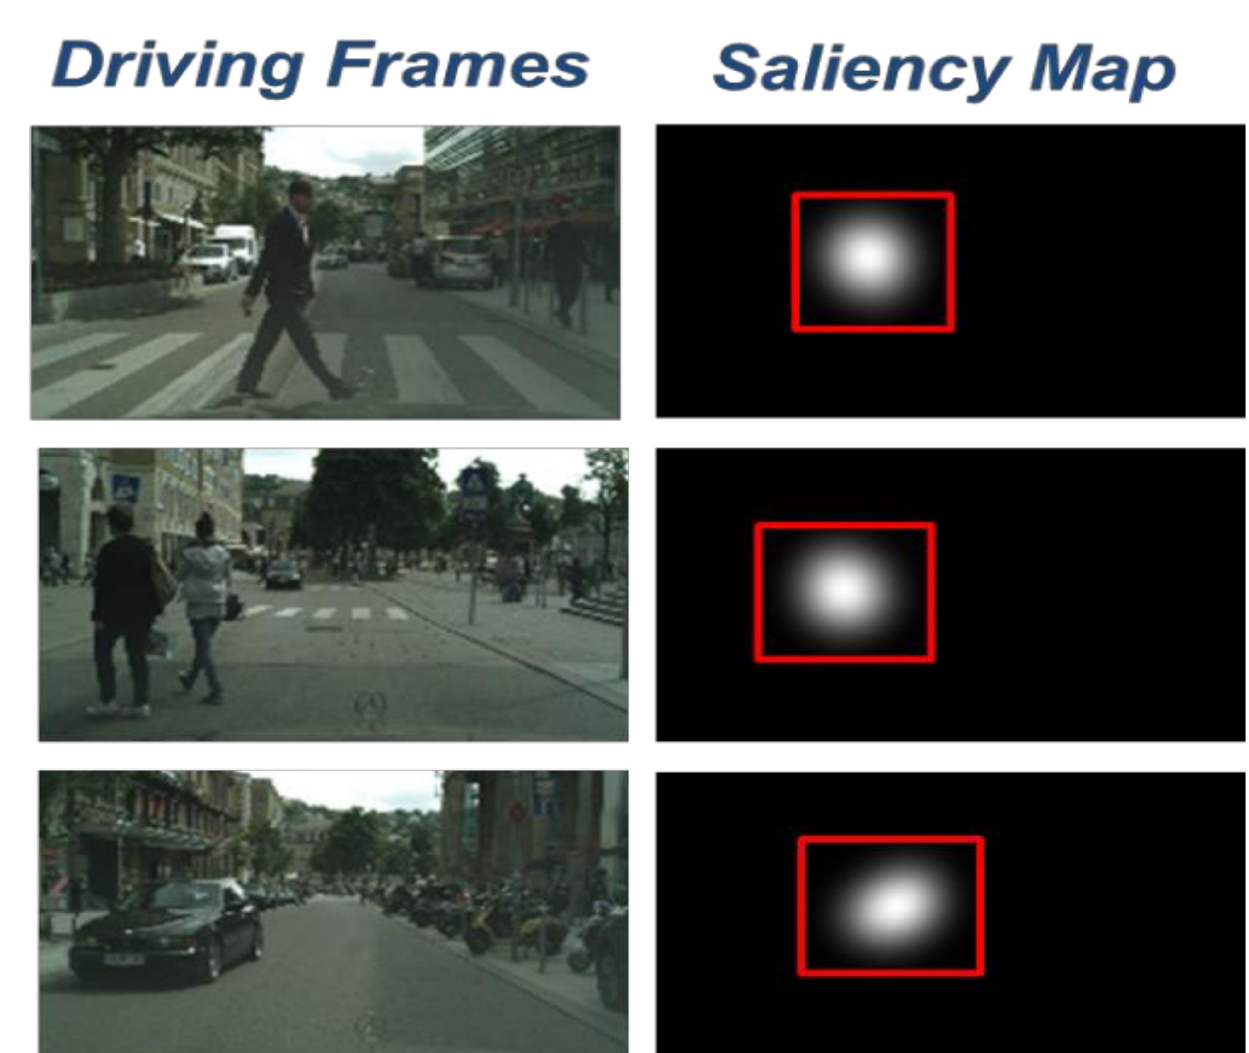
Figure 4. Bounding-box segmentation (red rectangular box) of the saliency